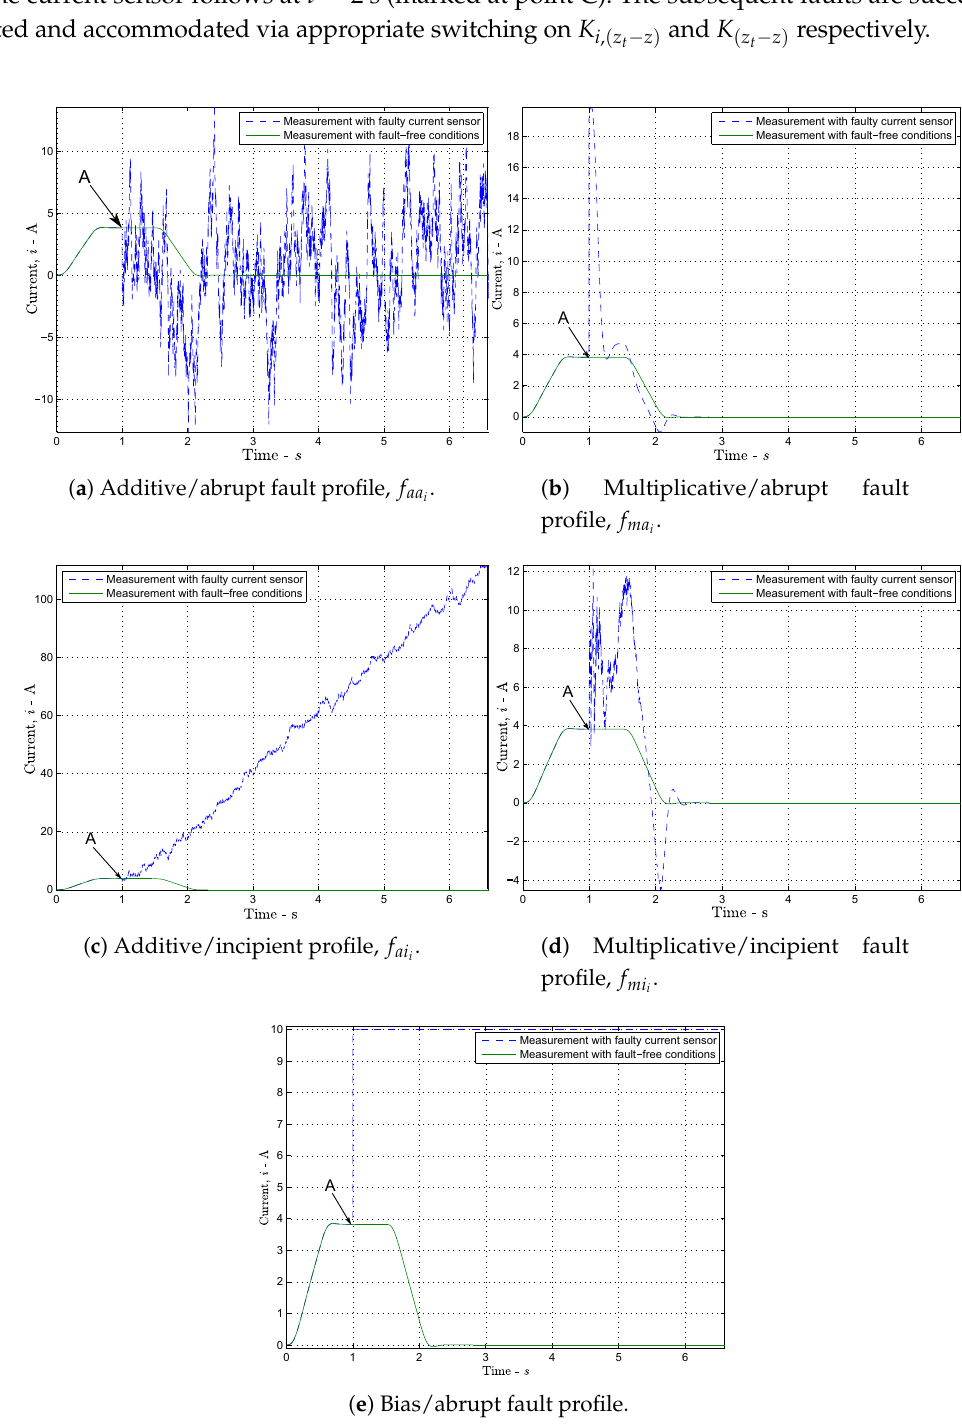
Figure 6. Coil’s current sensor, i , fault